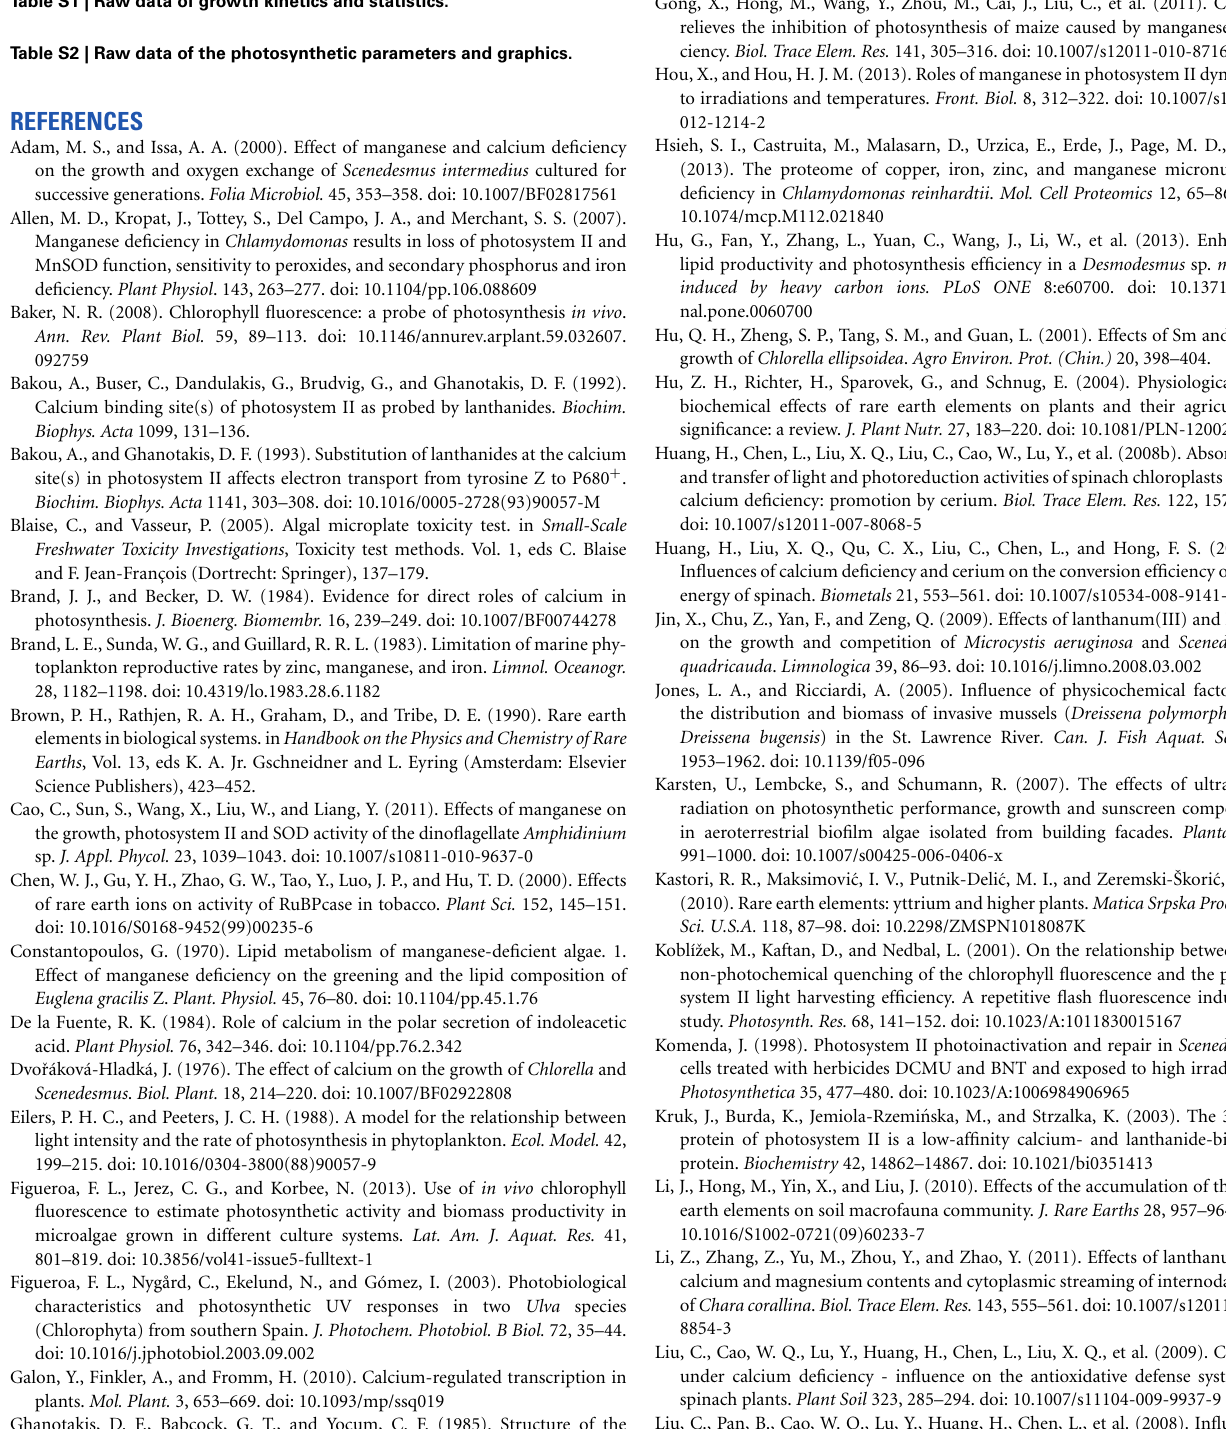
Table S1 | Raw data of growth kinetics and statistics. Table S2 | Raw data of the photosynthetic parameters and